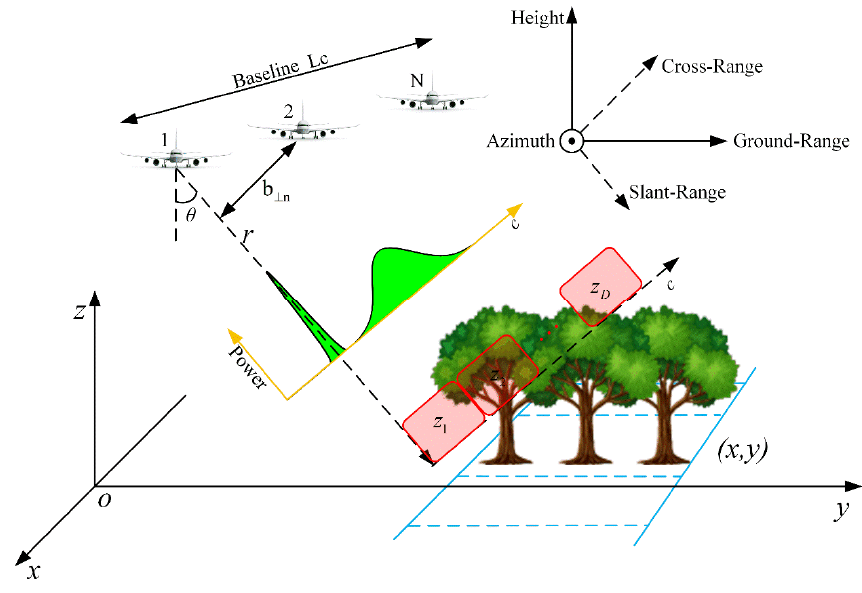
Figure 1. Geometry and spectral estimation of the tomographic synthetic aperture radar (TomoSAR) configuration.